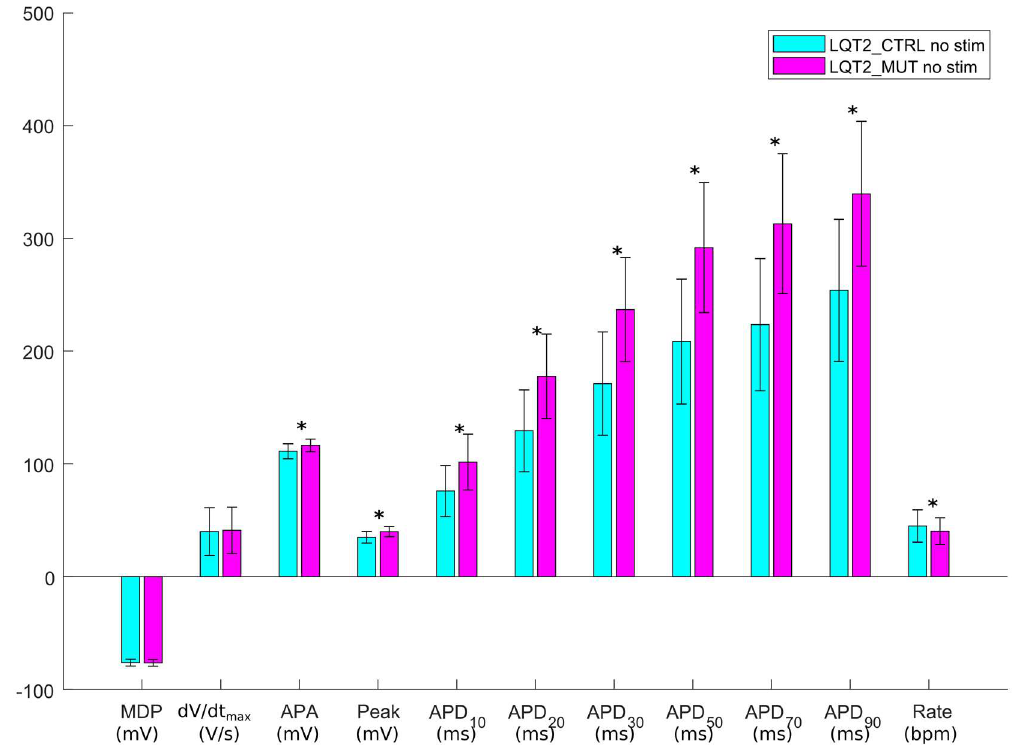
Figure 6. Comparison of the AP mean biomarkers computed on spontaneous APs in LQT2_CTRL (cyan) and LQT2_MUT (magenta). Error bars represent the standard deviation. Significant differences in the AP biomarkers are marked with a black star * (Mann-Whitney U -test, p -value < 0.01).